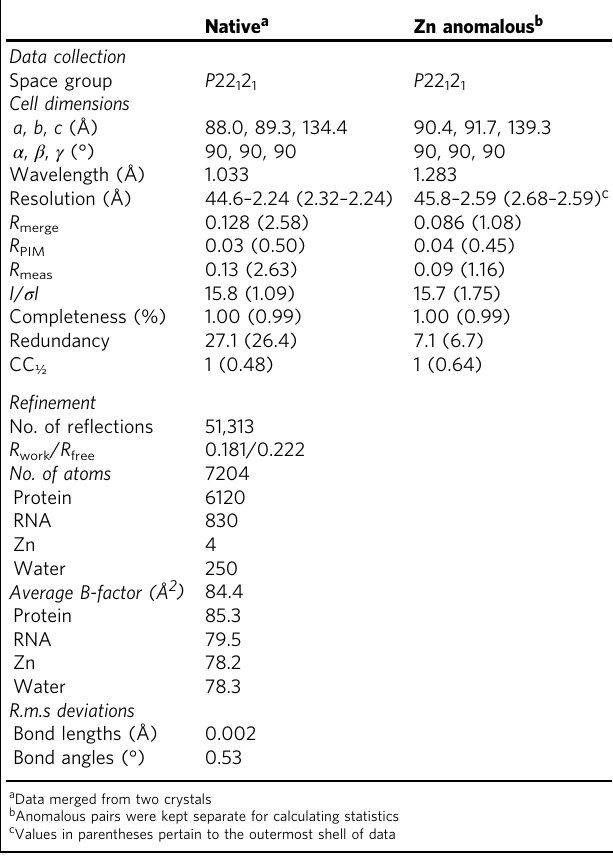
Table 2 Data collection and re fi nement